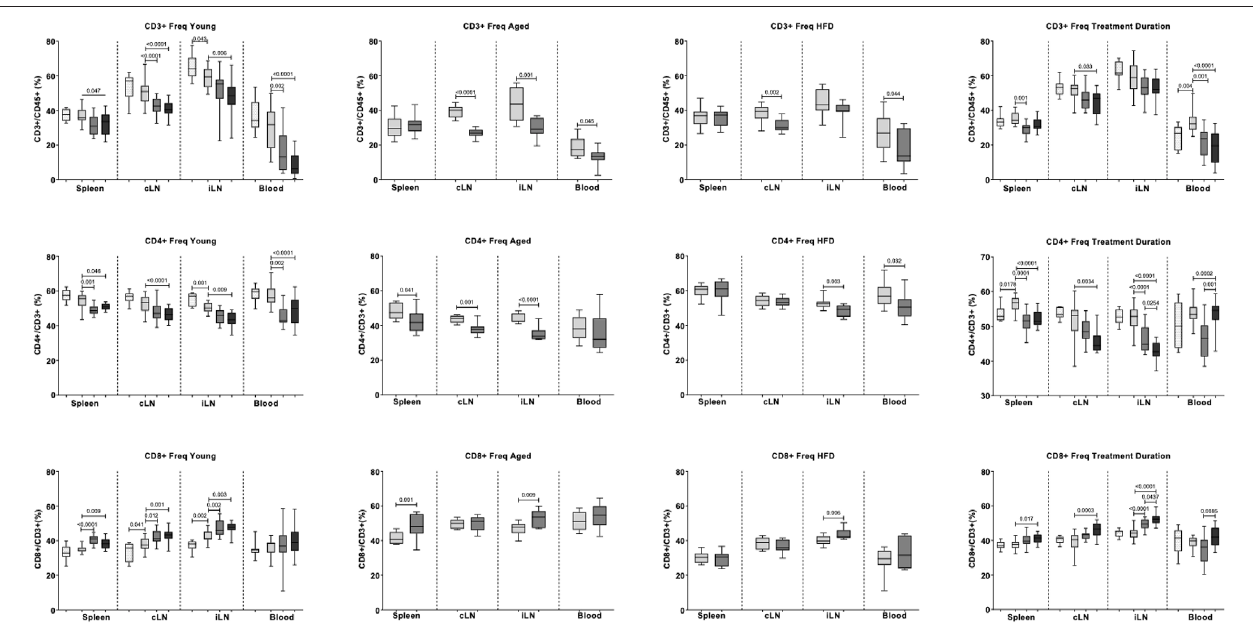
FIGURE 6 | Effects of fi ngolimod on the frequencies of CD3 + , CD4 + , and CD8 + cells in blood, cervical lymph nodes (cLN), inguinal lymph nodes (iLN) and spleen. Values obtained in the Dose Response, Aged, Atherosclerosis (High fat diet, or HFD) and Treatment Duration studies are shown as medians and con fi dence intervals (empty bars: naïve mice; light grey bars: saline-treated mice; middle and dark grey bars: 0.5 mg/kg and 1 mg/kg fi ngolimod-treated mice). Two-sided, independent- samples ttests assessed differences between twogroups. One-way analysis ofvariance (ANOVA) tests with post hoc Tukey ’ smultiple comparisons were used to investigate differences between three or more groups. p values are shown above the relevant